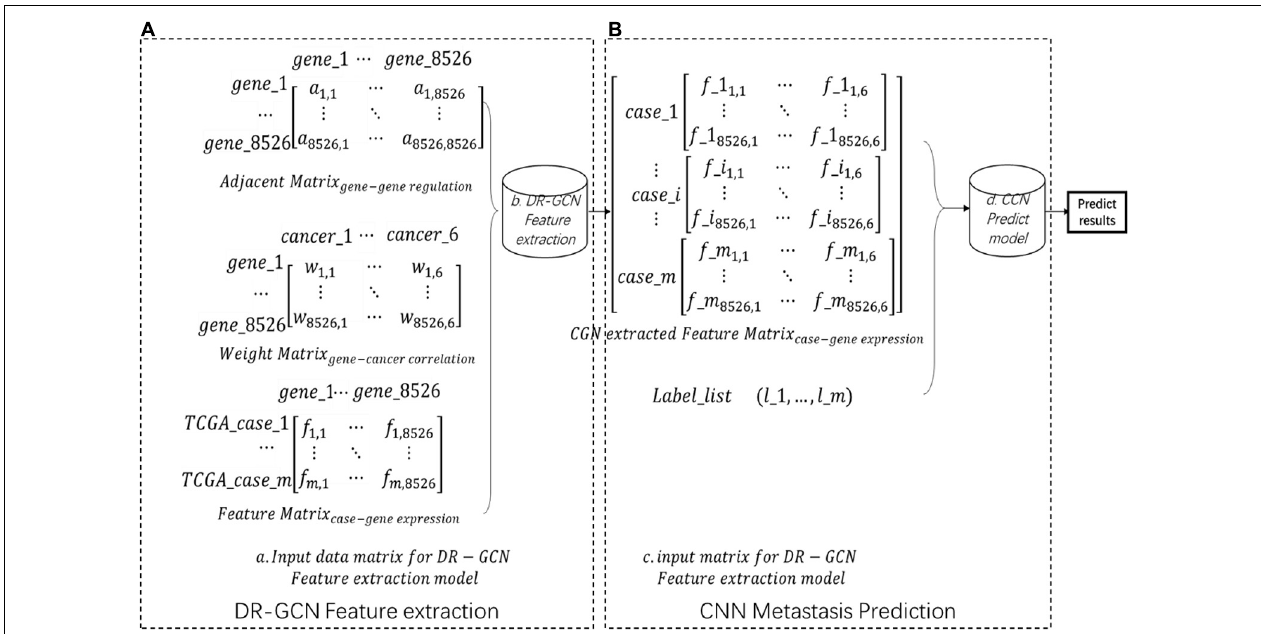
FIGURE 1 | Workflow (A) showing the input data matrix for directed relation-graph convolutional network (DR-GCN). Then, data were put into a DR-GCN feature extraction model. After feature extraction, we get a graph–structure data matrix as shown in panel (B) . Then, this data matrix combined label were put into a convolutional neural network prediction model. Finally, we got the prediction